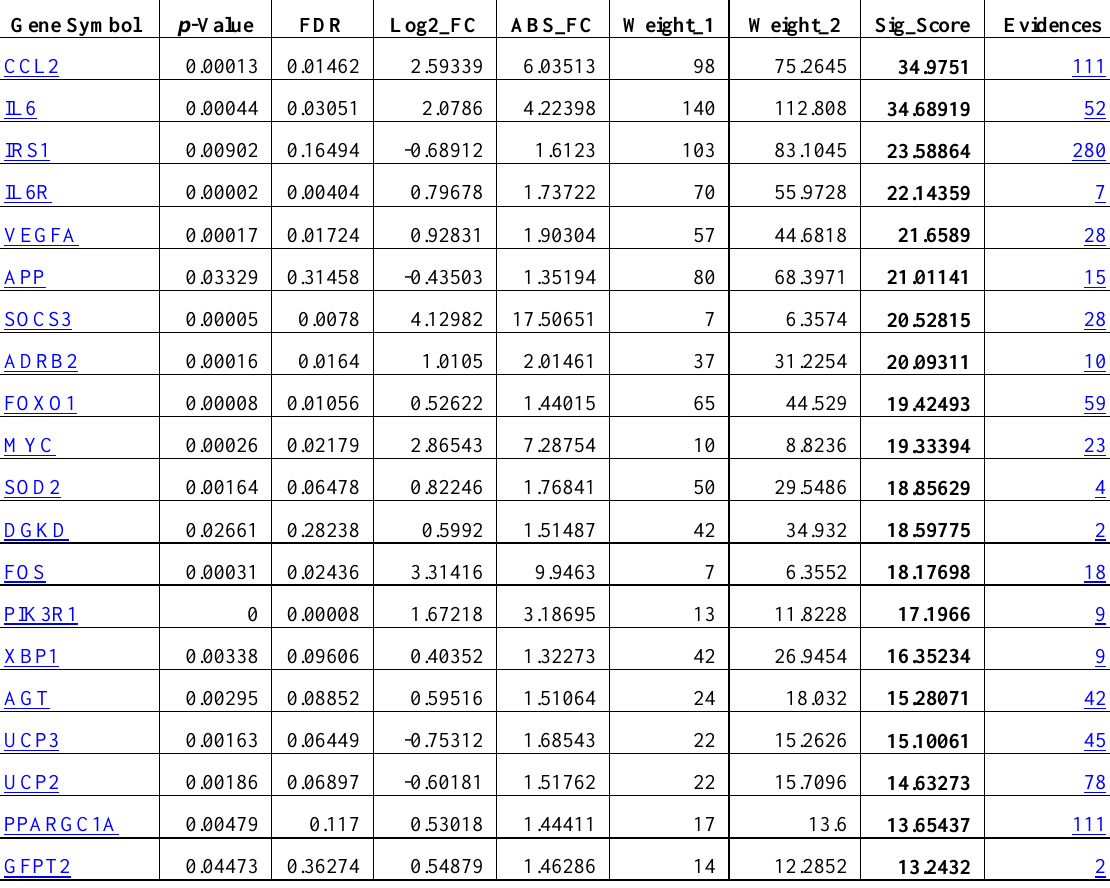
Table 5: Top-20 significant genes in IAB from GSE24215, ordered by Sig_Score, which is measured in the T2D-specific PPI network (PubMed >=0, h-Score >=0.45) for all the differential genes (FC>=1.3, p-value <=0.05 and AEL >=40% after applying Limma package in Bioconductor) in IAB from GSE24215. Note: Gene names are linked to GeneCards.org, UniProt IDs are linked to UniProt.org, and Evidences are linked to